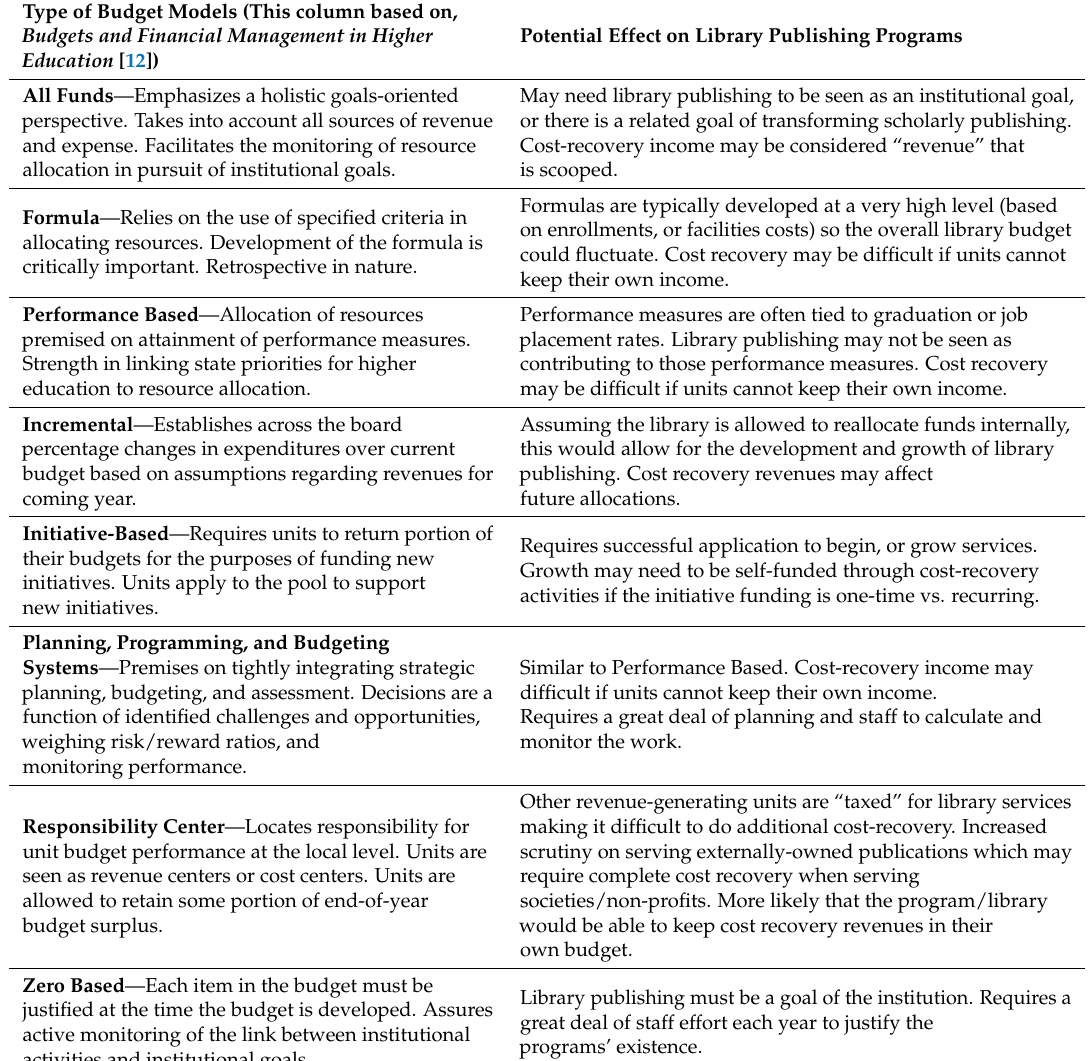
Table 1. Higher Education Institution Budget